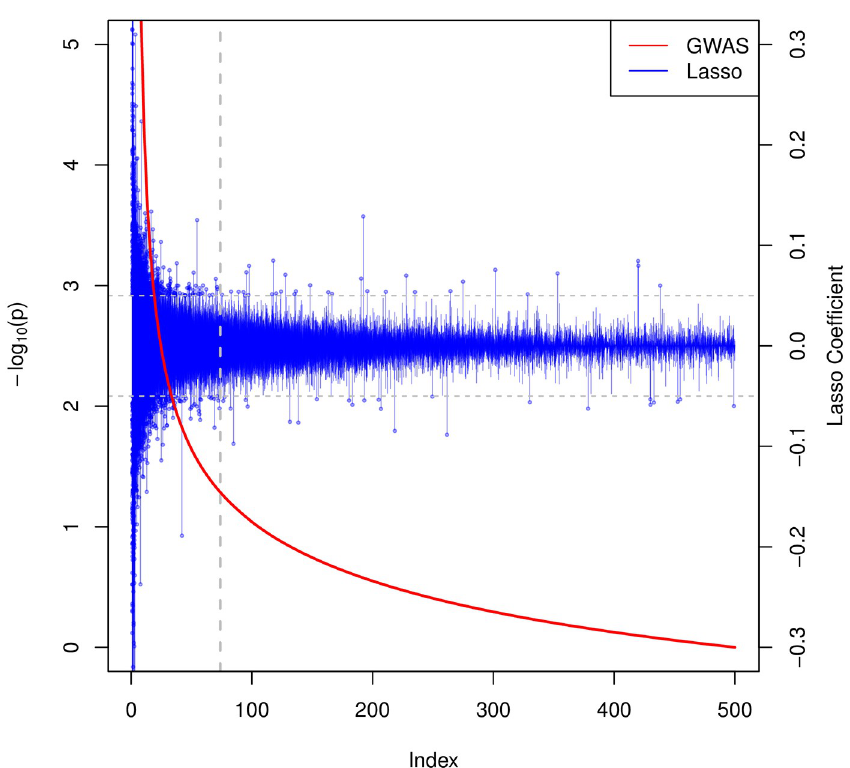
Fig 6. Comparison of the lasso coefficients and univariate p -values for height. The index on the horizontal axis represents the SNPs sorted by their univariate p -values. The red curve associated with the left vertical axis shows the − log 10 of the univariate p -values. The blue bars associated with the right vertical axis show the corresponding lasso coefficients for each (sorted) SNP. The horizontal dotted lines in gray identifies lasso coefficients of ± 0.05. The vertical one represents the 100K cutoff used in [21].